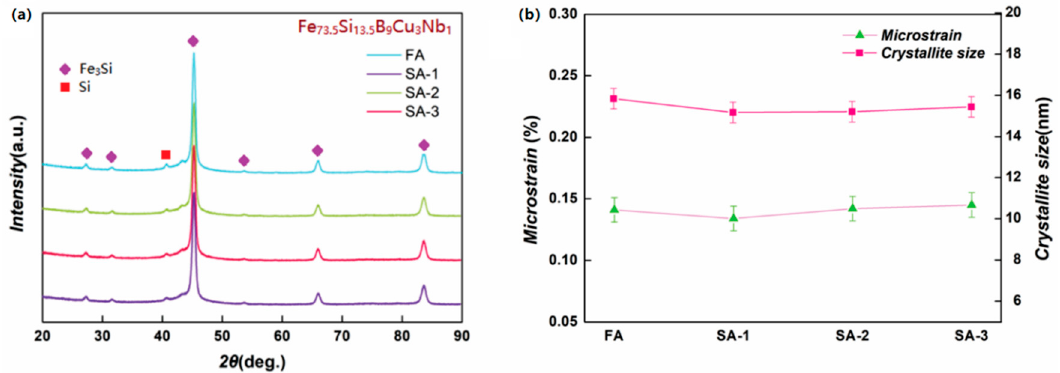
Figure 2. ( a ) XRD plots for nanocrystalline soft magnetic cores annealed at different conditions. ( b ) The microstrain and crystallite size as a function of the extent of stress annealing.